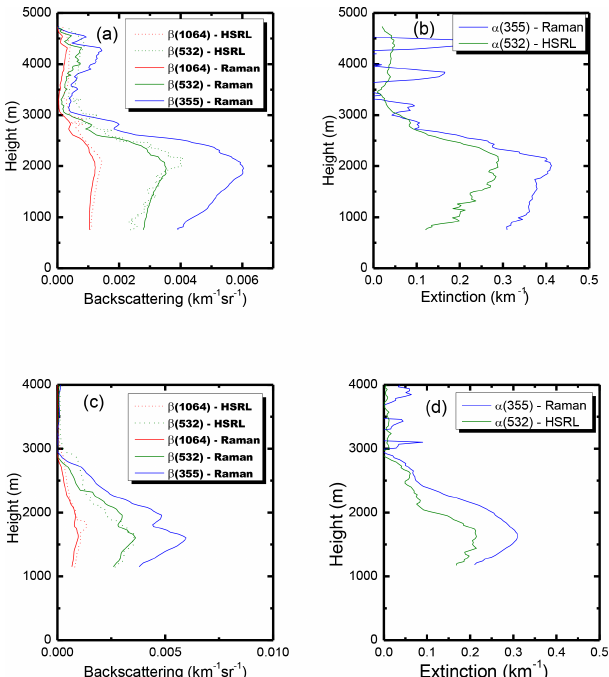
Figure 5. Vertical profiles of backscattering ( β ) and extinction ( α ) measurements obtained by ground-based Raman lidar and air- borne HSRL-1 at NASA Goddard Space Flight Center on (a–b) 29 July 2011 at 20:00UTC and (c–d) 22 July 2011 at 18:35UTC. The ground-based Mie–Raman measurements provided indepen- dent measurements of backscattering and extinction coefficients at 355nm, while the airborne HSRL-1 system provided those for 532nm. For 1064nm, both instruments provided only backscatter- ing